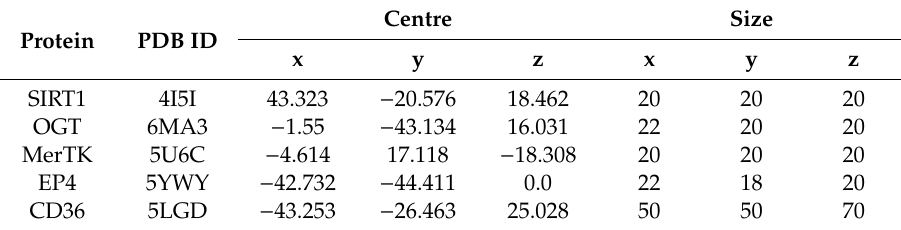
Table 2. The parameters of the molecular docking